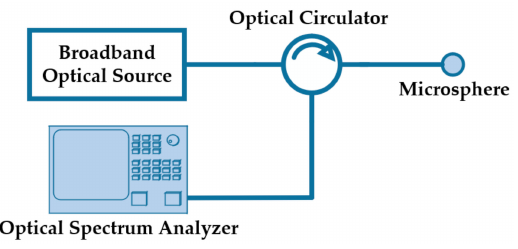
Figure 1. Schematic diagram of the interrogation setup.